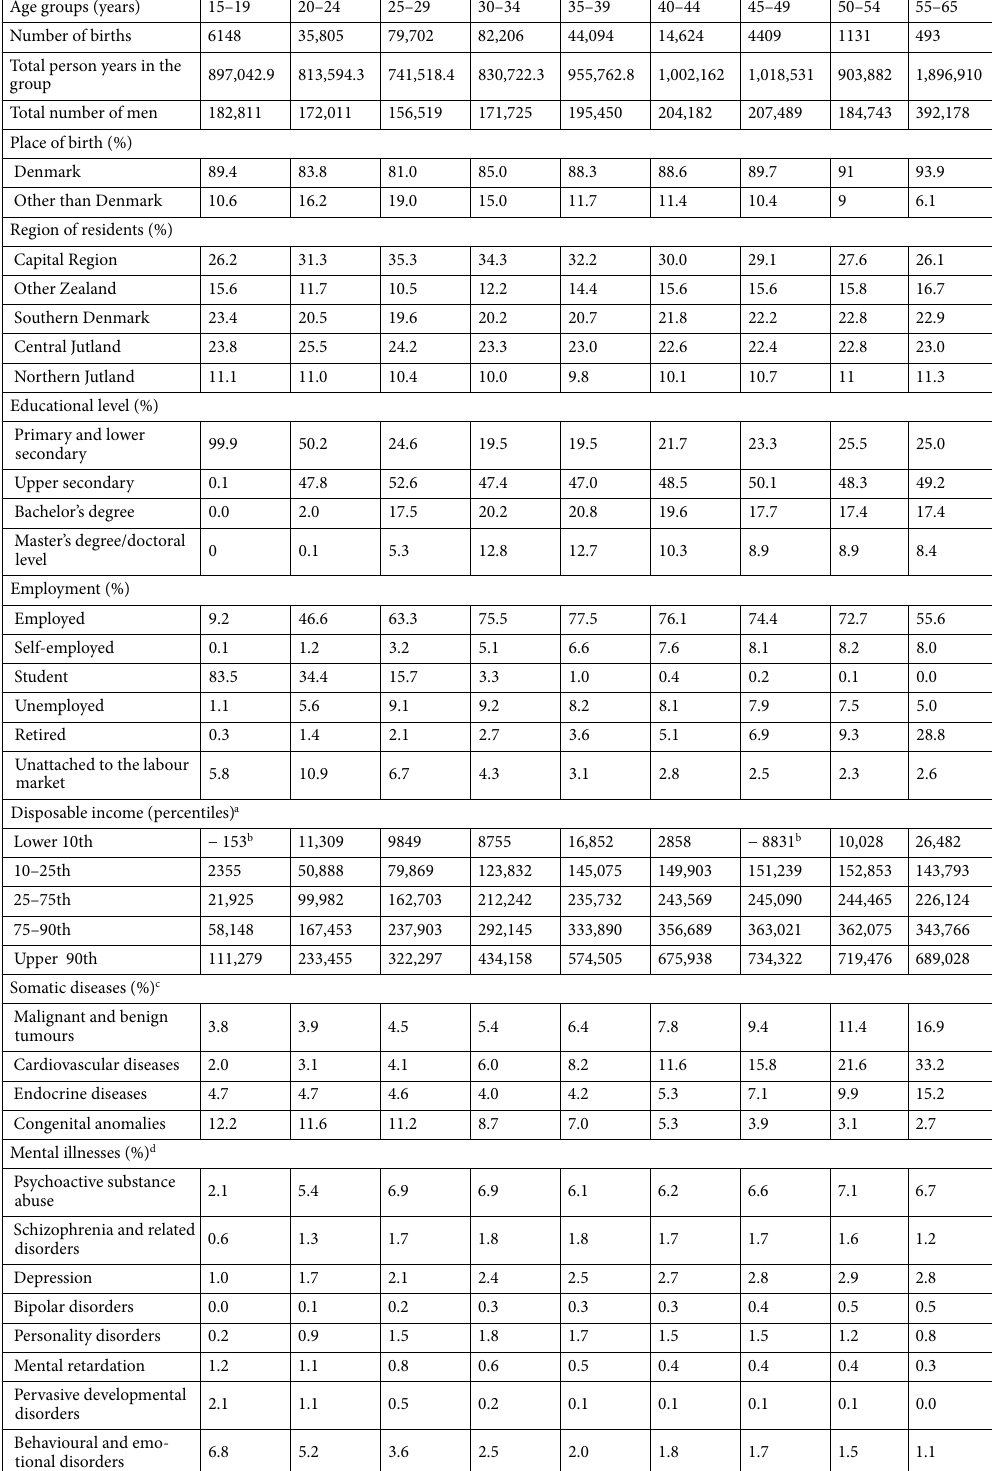
Table 1. Sociodemographic and health characteristics according to the age of the man at January 1st 2011. Results are according to conditions that prevailed in 2010 for all men aged 15–65 years living in Denmark January 1, 2011 divided into age groups. Numbers are shown as percentage distribution unless described otherwise. a Disposable income is shown as the average disposable income (rounded) for the year 2010 for each age